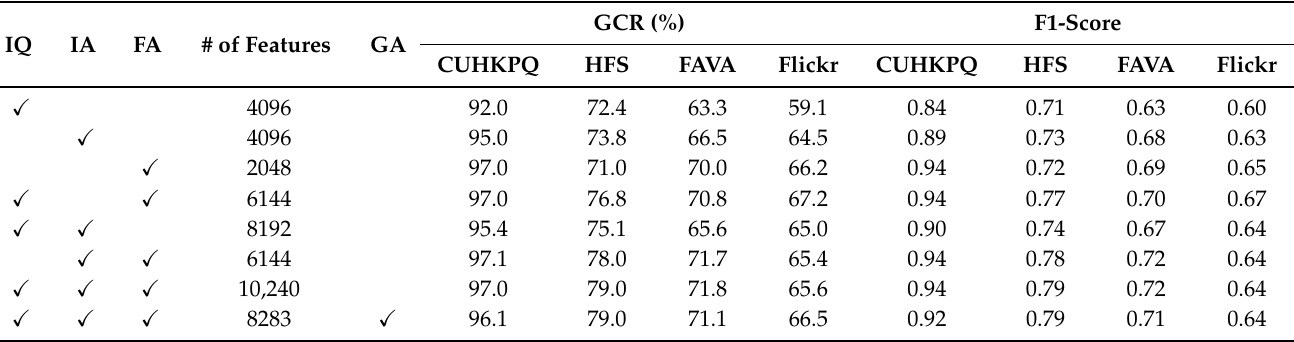
Table 3. Results for the aesthetic quality categorization for each database by extracting perceptual features from the face region.